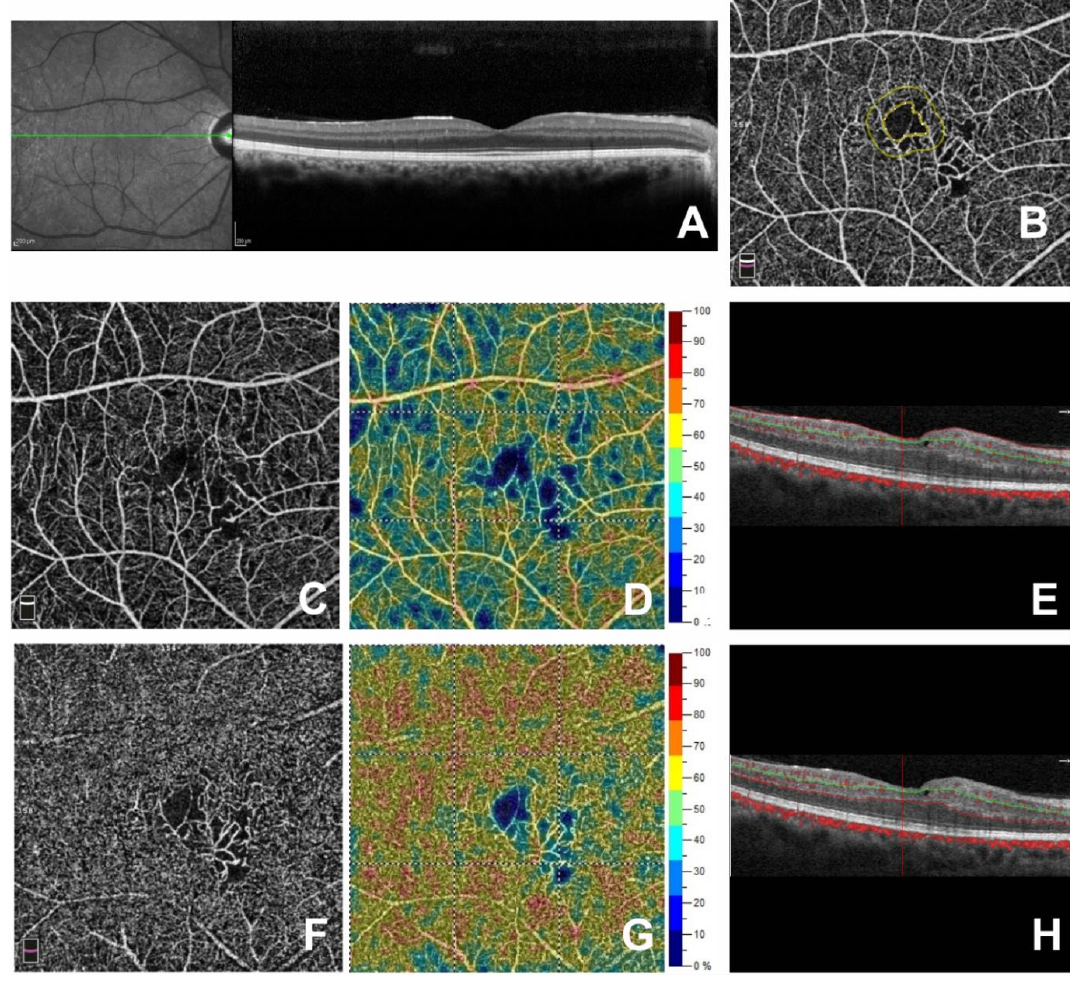
Figure 2. Right eye of a 37-year-old patient affected by Radiation Maculathy after Ranibizumab injections at the last follow up to one year. ( A ) Spectral Domain-Optical Coherence Tomography (SD-OCT) B-scan revealed a decreased central foveal thickness, absence of intraretinal cysts, and subfoveal exudative detachment. In OCT Angiography (OCTA) images in the macular region, no change was found in the Foveal Avascular Zone area with ( B ) respect to baseline (Figure 1), the capillary rarefaction persisted in the Superficial Capillary Plexus and Deep Capillary Plexus ( C,F ) with a decreased vessel density ( D,G ). OCTA B-scan showed the segmentation of the retinal plexuses ( E,H ). Schematic graphs showing the measurements of SD-OCT, OCTA parameters and BCVA after each intravitreal injection during a 1 year follow up were reported in Figure 3.